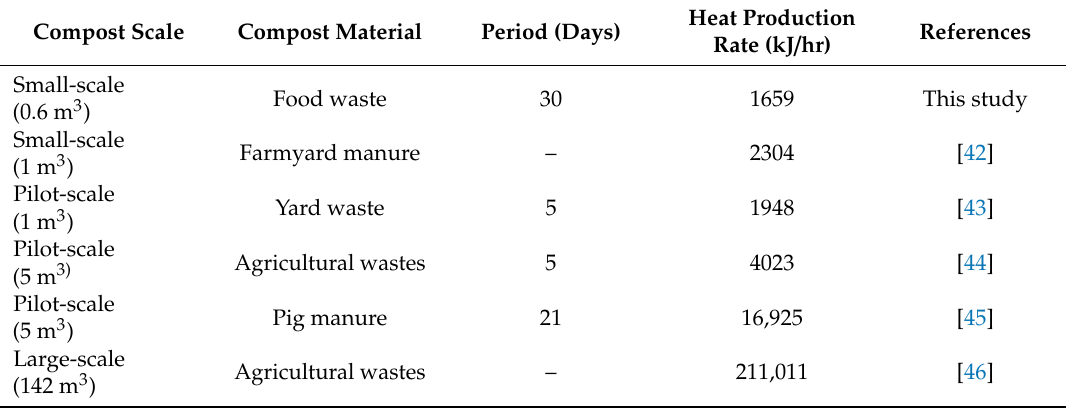
Table 4. Comparison of heat production rates of di ff erent compost